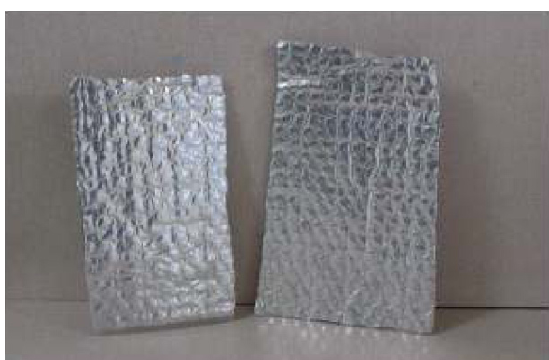
Figure 3. Reflective insulation foils.